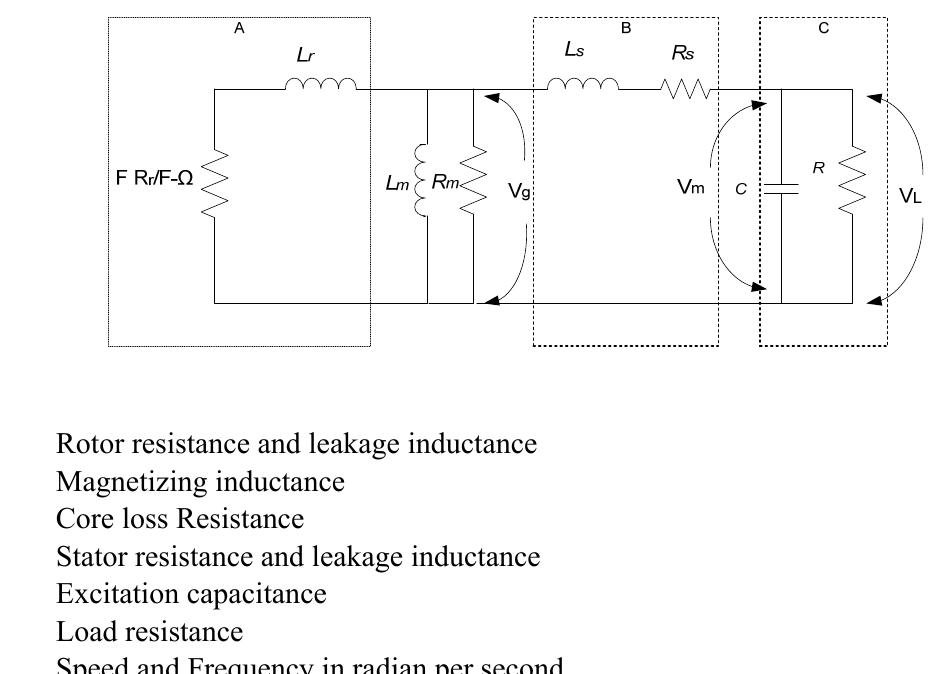
Figure 1. Single phase equivalent circuit of the IG